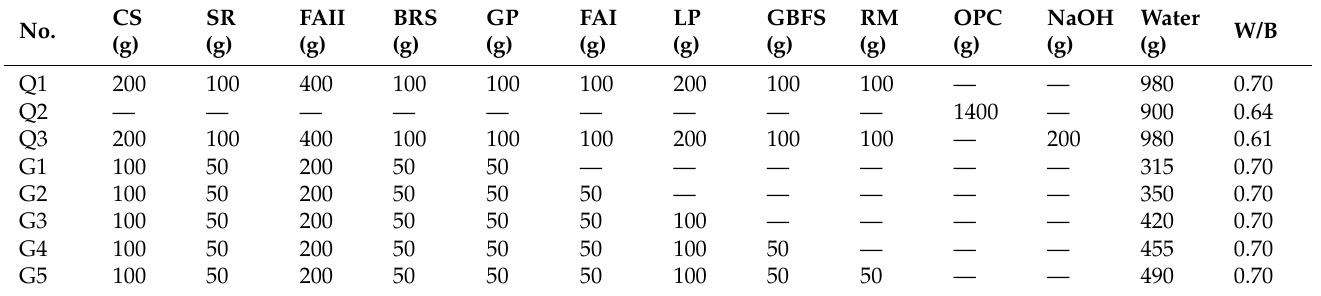
Table 2. The designed mixing proportions of backfill pastes for physical and mechanical properties, as well as microcharacterization.